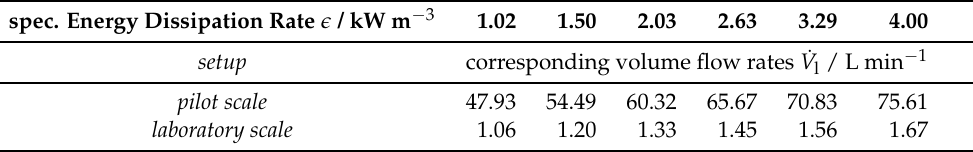
Table 3. Investigated specific energy dissipation rates (cid:101) and scaled liquid volume flow rates ˙ V l of water in the pilot- and laboratory-scale